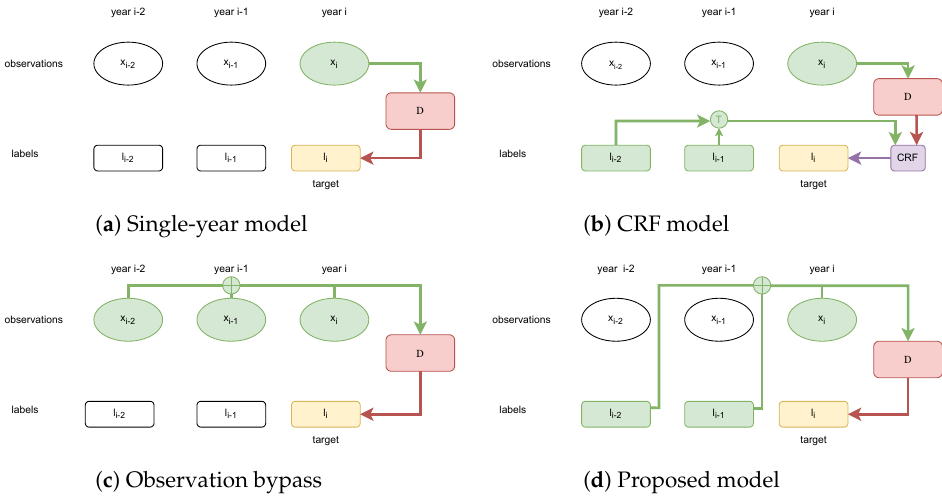
Figure 4. Multi-Year Modeling. Different approaches to model crop rotation dynamics: ( a ) the model only has access to the current year’s observation; ( b ) a chain-CRF is used to model the influence of past cultivated crop; ( c ) the model has access to the observation of the past two years; ( d ) proposed approach: the model has access to the last two declared